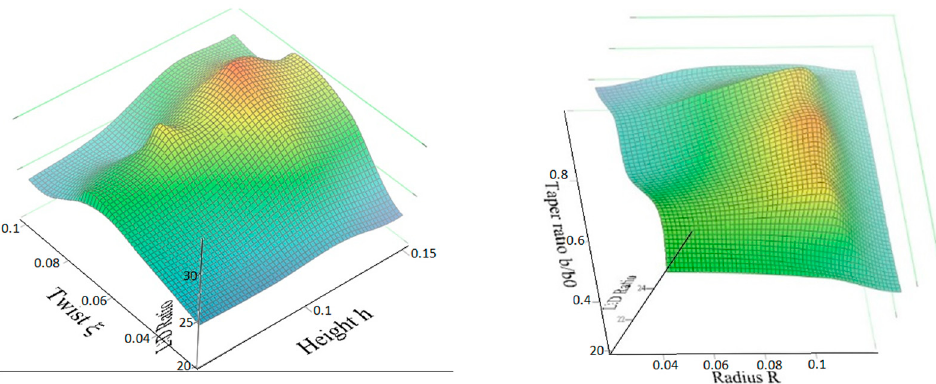
Figure 10. Response surfaces revealing ranges of values of winglet geometrical dimensions’ combinations yielding near maximum L / D ratio of winglet-equipped DLR-F4 at M = 0.75 and α = 3°.